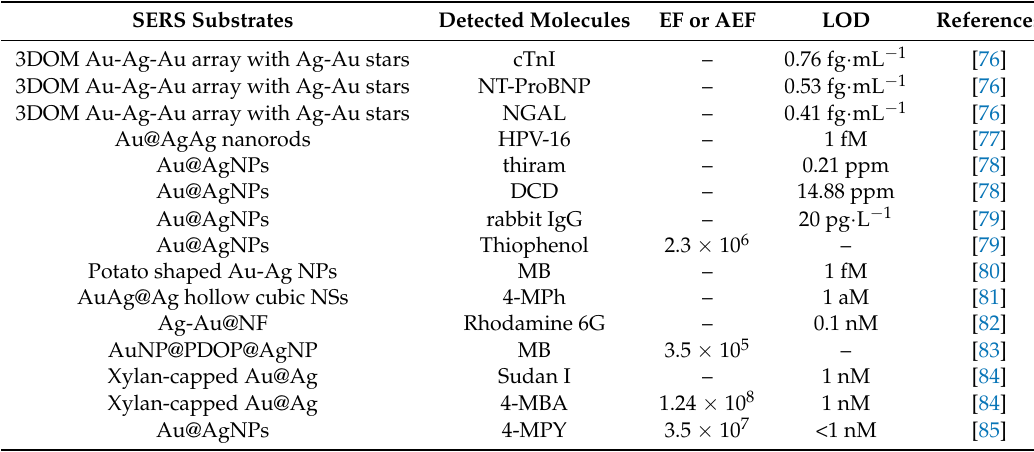
Table 2. SERS performances of bimetallic nanoparticles for biological/chemical sensing (4-MBA = 4-mercaptobenzoic acid; cTnI = cardiac troponin; NT-ProBNP = N-terminal prohormone of brain natriuretic peptide; NGAL = neutrophil gelatinase-associated lipocalin; HPV-16 = human papillomavirus DNA type 16; DCD = dicyandiamide; 4-MPY = Mercaptopyridine; MB = Methylene blue; 4-MPh = 4-mercaptothiophenol; PDOP = Polydopamine). SERS Substrates Detected Molecules EF or